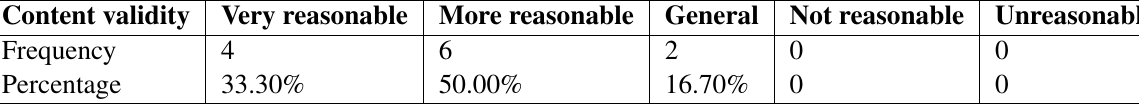
Table 4 Test of structural validity of